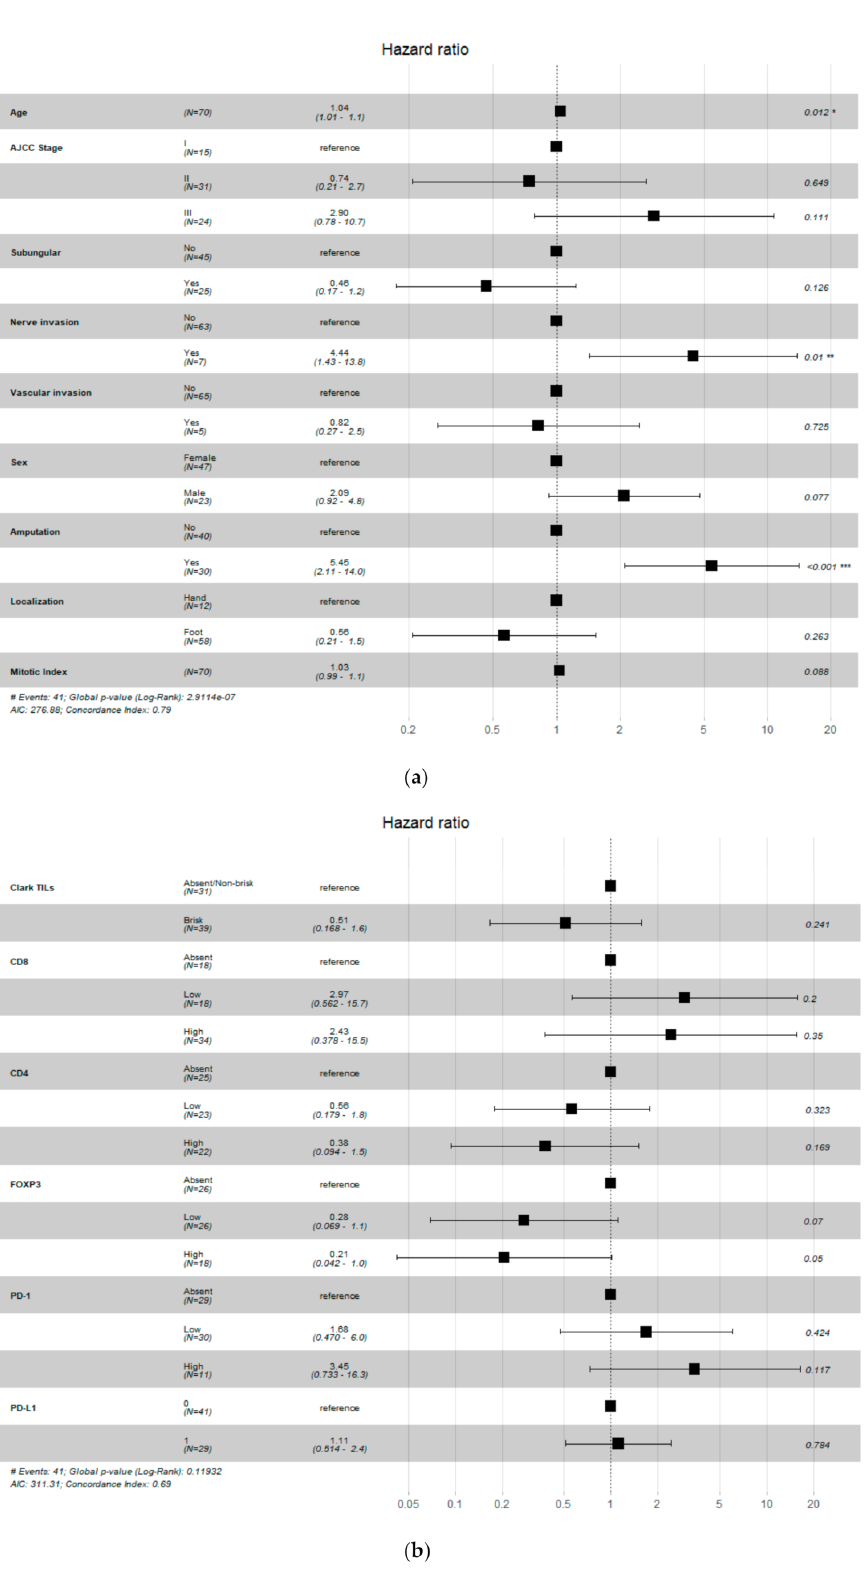
Figure 6. Multivariate analysis of ( a ) clinical and pathological features and ( b ) immunohistochemical features shown in Forest Plot. Significance code for p -value *** [0, 0.001] ** (0.001, 0.01] * (0.01,